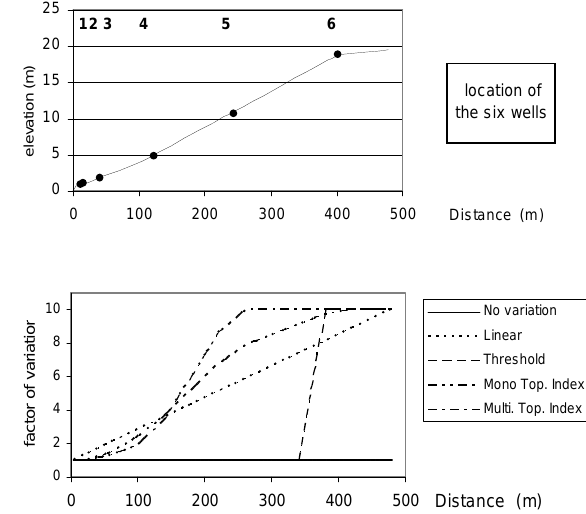
Fig. 4. Normalized factor of spatial variation of the hydraulic conductivity from the bottom to the top domain, for different spatial